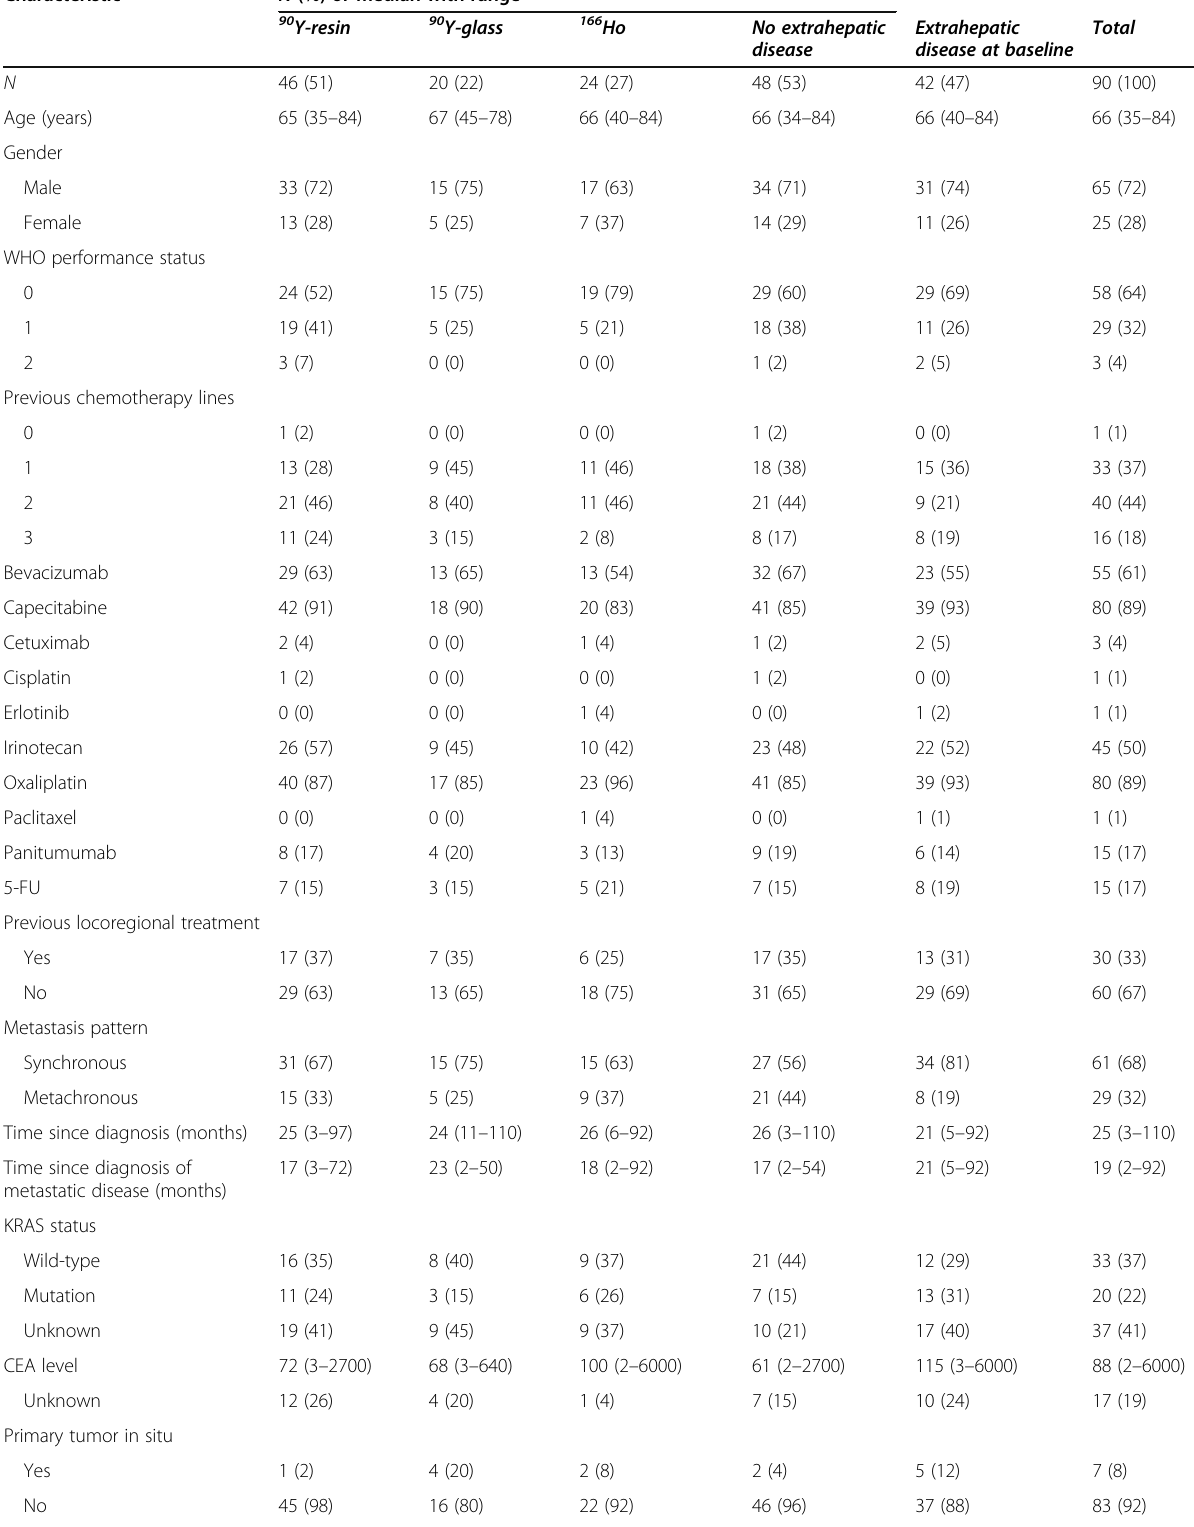
Table 1 Baseline and treatment